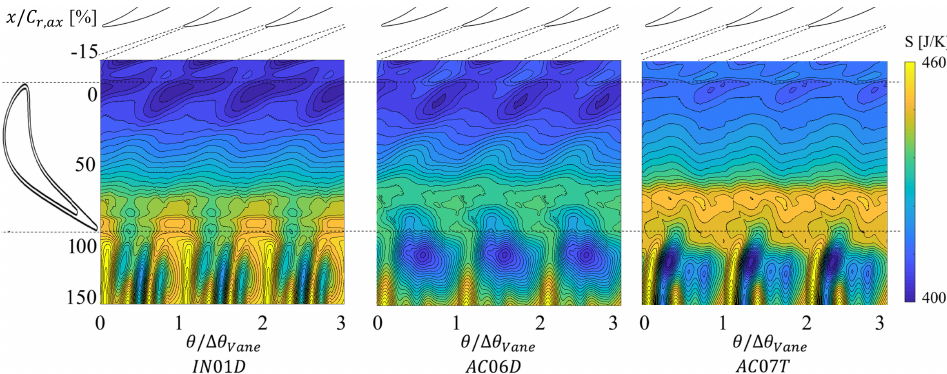
Figure 6. Contours of time-average mid-gap entropy in the vane frame for (left to right): IN01D, AC06D, and